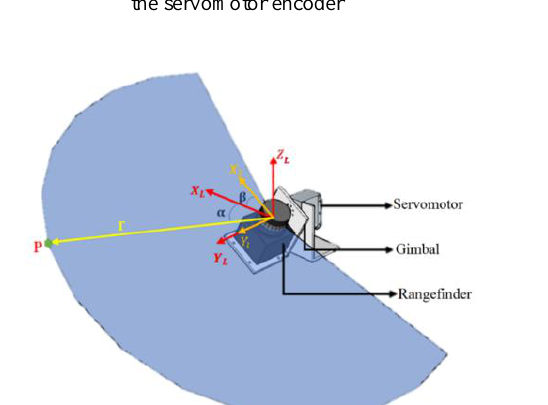
Figure 3. The structure of the 3D LRF system includes a 2D LRF and a servomotor connected by a